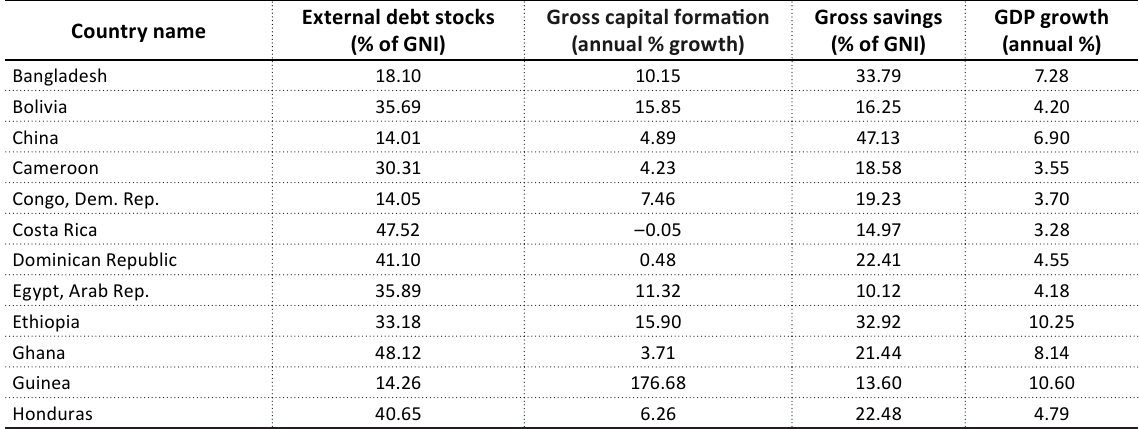
Table H1. Grouping of countries by level of economic